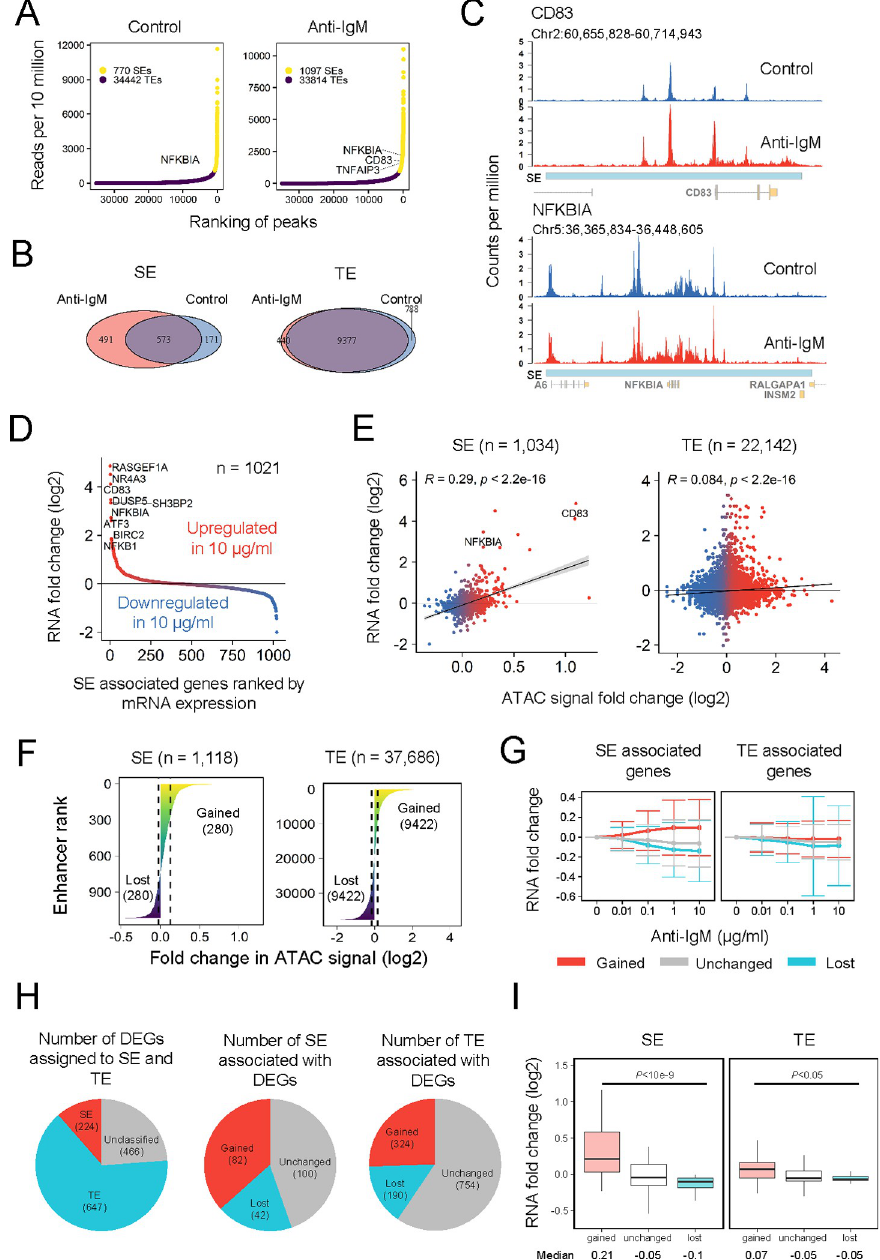
Fig 3. SE analysis. (A) Plot of SEs determined using the ROSE algorithm [13] from cells with and without anti-IgM stimulation. (B) Venn diagram showing the number of genes assigned to SEs and TEs obtained from each stimulatory condition. Genes with multiple enhancers were assigned only to one enhancer, whereas gene with both SE and TE were assigned to SE. (C) ATAC-seq track view of NF- κ B target genes in B cell CD83 and NFKBIA SEs in control and 10 μ g/mL anti-IgM-stimulated DT40 chicken cells. (D) Scatter plot of the mean fold-change of SE-associated genes between 10 μ g/mL anti-IgM stimulated and control cells. Genes with multiple SEs were counted once. (E) Correlation plot between TE and SE annotated peaks and the associated genes. Peaks associated with both SE and TE were assigned to SE. Genes with gene expression 0 across all doses were removed. RNA fold change was calculated between the mean of 10 μ g/mL anti-IgM stimulated and control cells. (F) Regions with ATAC log2 fold changes signal more than the upper quantile were annotated as gained SEs/TEs and lower than the lower quantile were annotated as lost SEs/TEs. (G) Anti-IgM dose-response of fold change in the RNA level. Fold change was calculated from scRNA-seq by averaging the expression across all cells in the same stimulatory condition compared to dose 0. Number of genes: Gained SE, 260; Unchanged SE, 522; Lost SE, 239; Gained TE, 3598; Unchanged TE, 5384; Lost TE, 520. (H) Pie